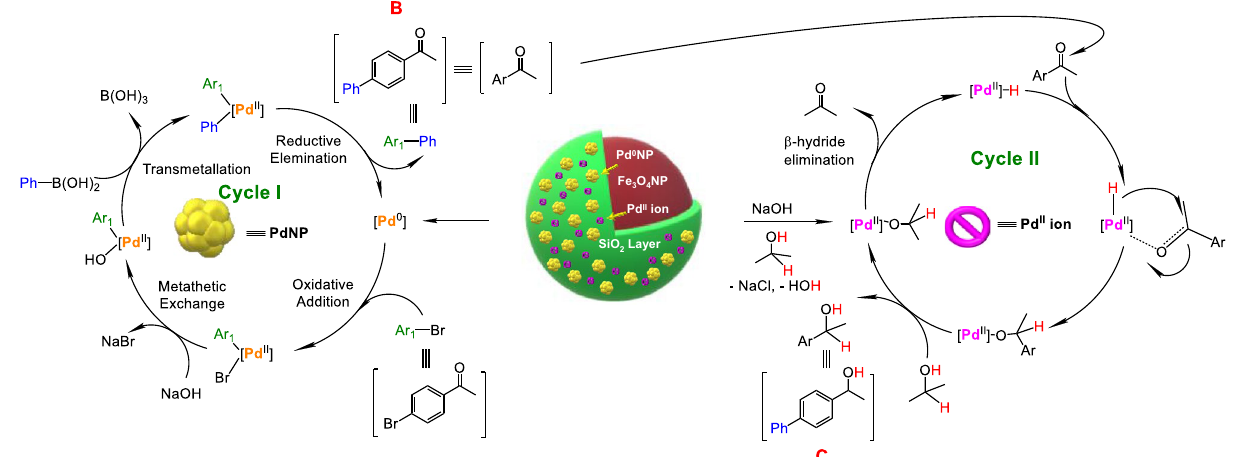
Figure 5. Plausible mechanism for tandem Suzuki coupling/transfer hydrogenation reaction catalysed by